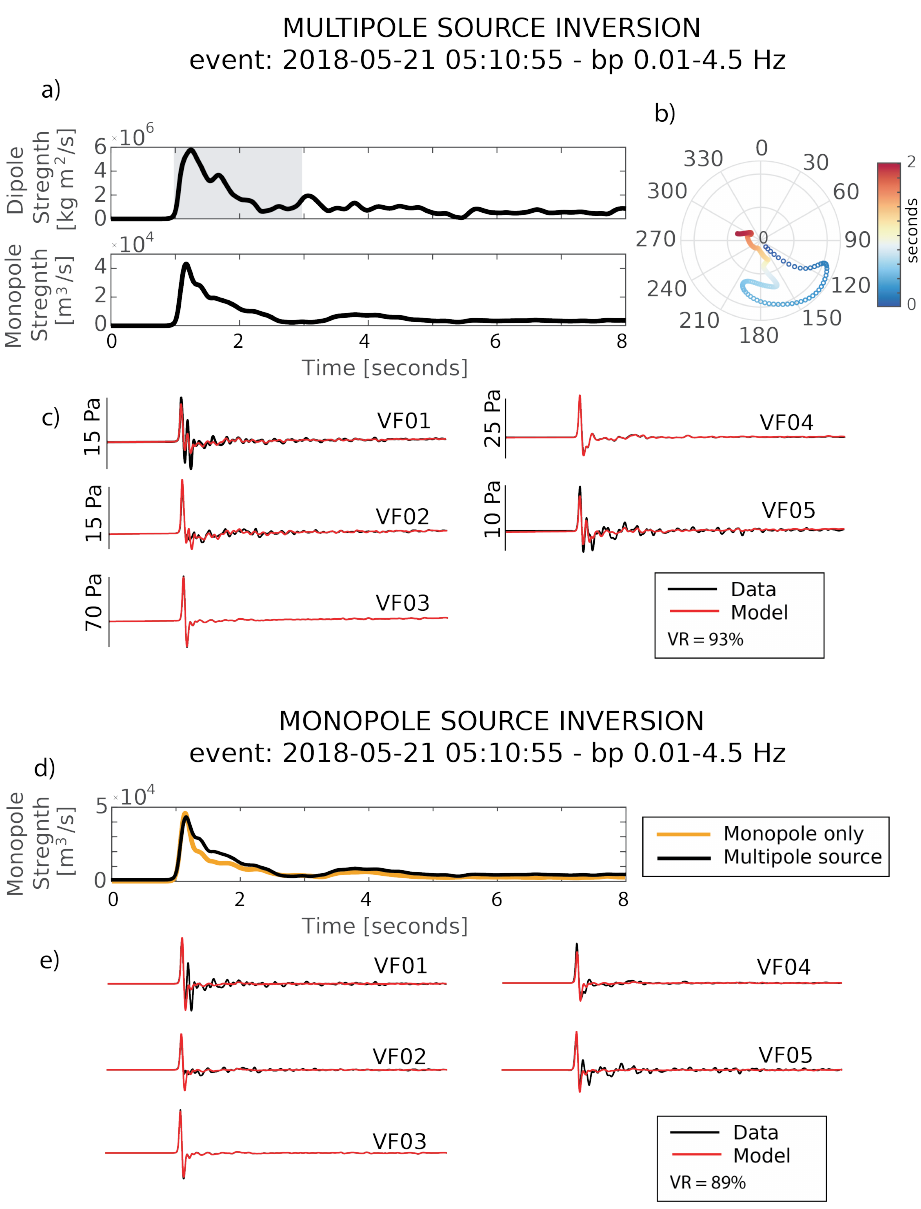
Figure 7. Comparison of acoustic multipole and monopole-only source inversions for an explosion recorded in May 2018 at Fuego, Guatemala: ( a ) monopole and (horizontal) dipole source time functions obtained from multipole inversion; ( b ) dominant direction of the horizontal dipole over the source time function (grey shaded segment in ( a )); ( c ) waveform fit between data and model; ( d ) comparison of volume flow rates obtained from monopole-only (yellow) and multipole (black) inversions; and ( e ) waveform fit between data and model for monopole-only inversion. Note that these inversions are based on a representation of the acoustic wavefield as in Equation (10). VR is variance reduction (please, see Equation (14) in main